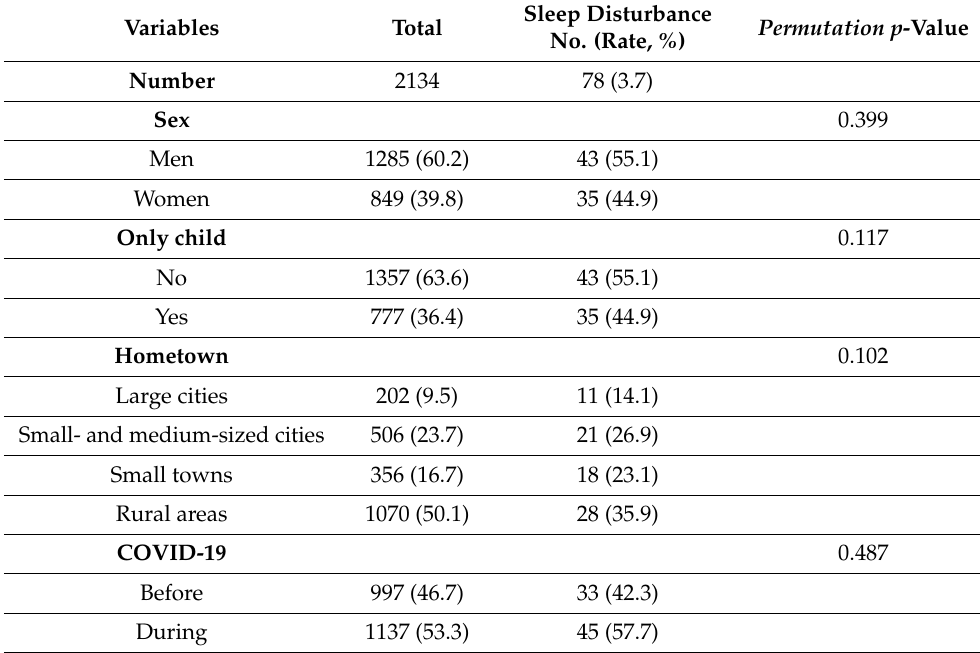
Table 2. Prevalence and comparison of sleep disturbance stratified by different sociodemographic characteristics of college students with mental health problems ( n